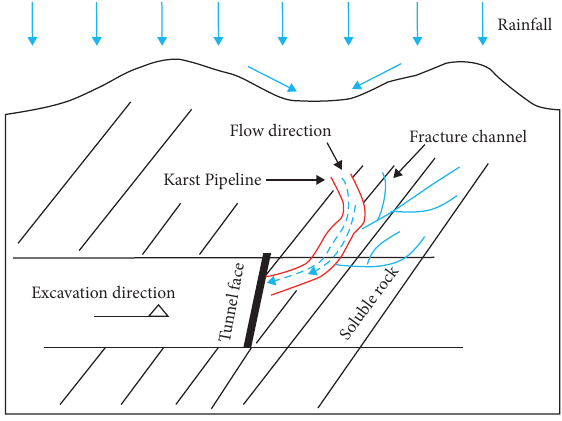
Figure 5: Diagram of water inrush in a karst pipeline.